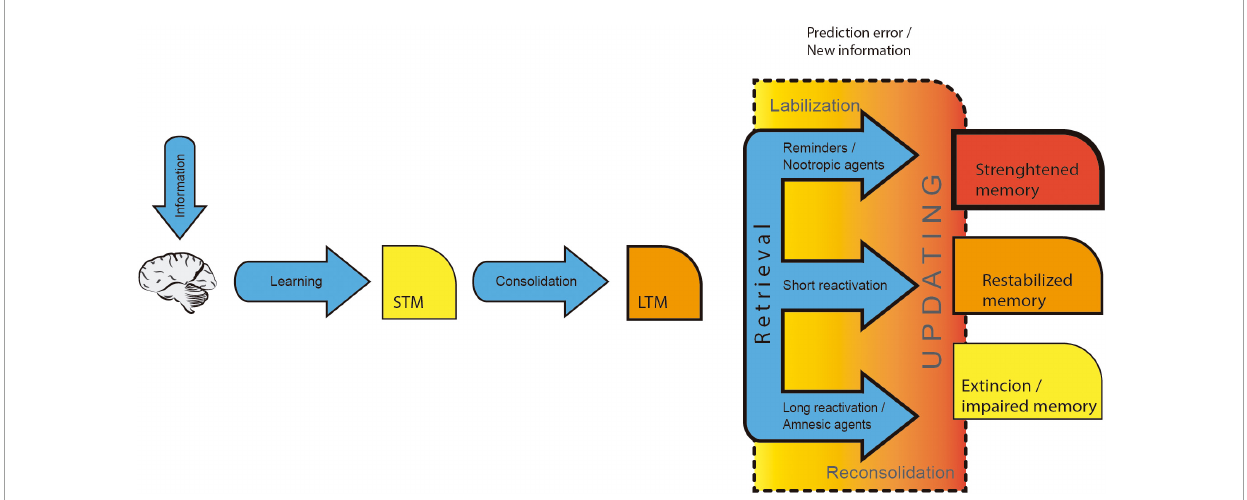
FIGURE1 Long-term memory stages. Exteroceptive and interoceptive information is encoded during learning and subsequently stabilized into long-term memory through memory consolidation. Integrated memories are recalled throughout retrieval when they are reactivated and expressed. Furthermore, memory updating occurs only when new information is integrated into the previously formed memory